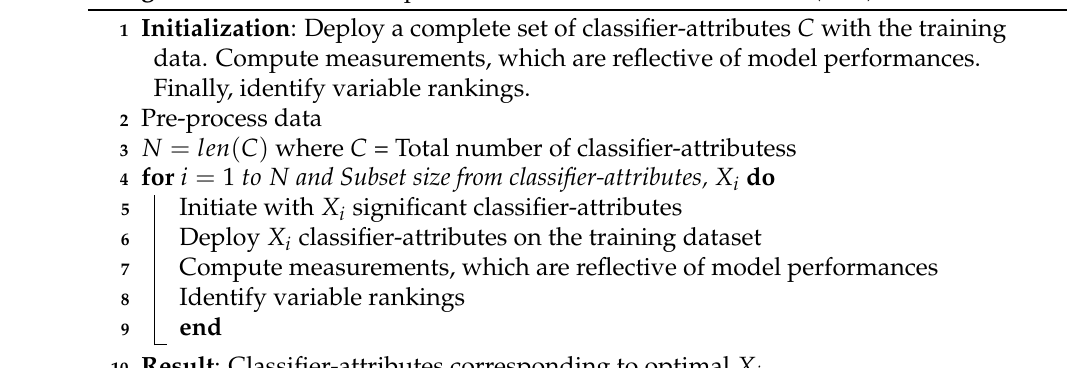
Algorithm 1: Followed steps for Recursive Feature Elimination (RFE)